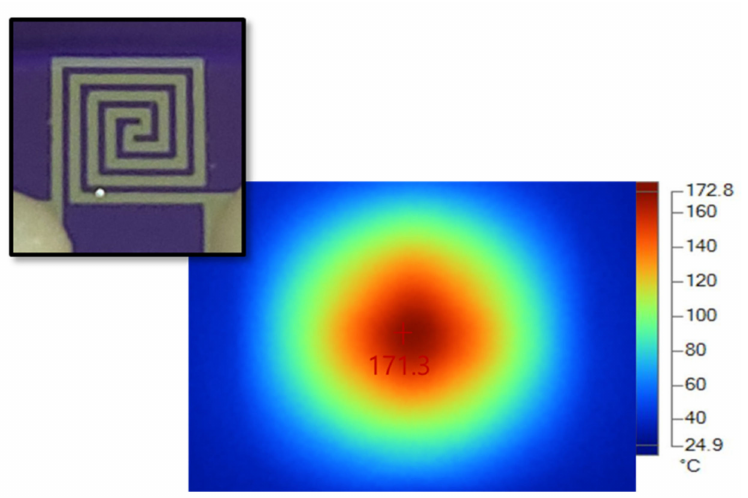
Figure 7. The image ( left ) and infrared camera image ( right ) of applying 10 V to a microconstruction redesigned for generating high